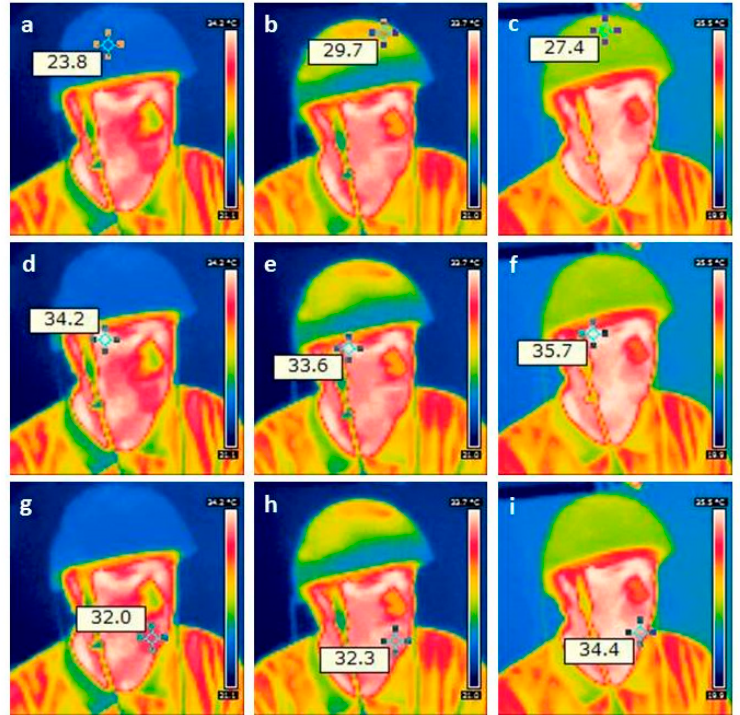
Figure 4. Results from thermal imaging of the first pilot measurement using the new stimulation helmet. Note the increase in temperature on the helmet (upper row; a before, b during, and c after stimulation) on the forehead (middle row; d–f) and on the chin (lower row; g–i).